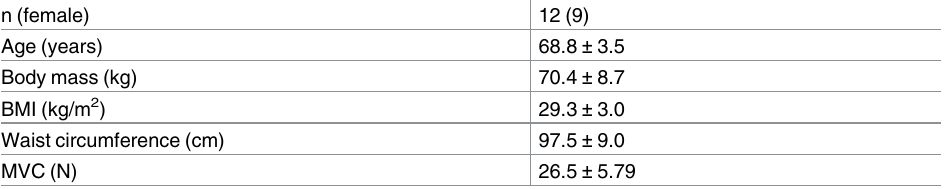
Table 1. Baseline characteristics of the subjects completing the study.